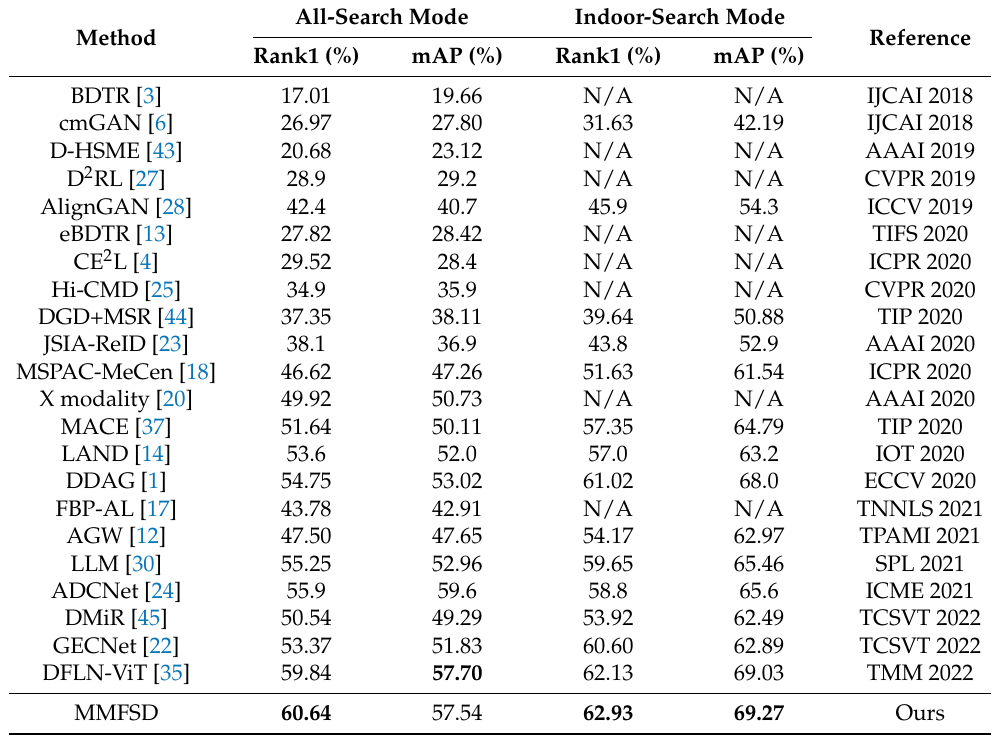
Table 1. The performance comparison on the SYSU-MM01